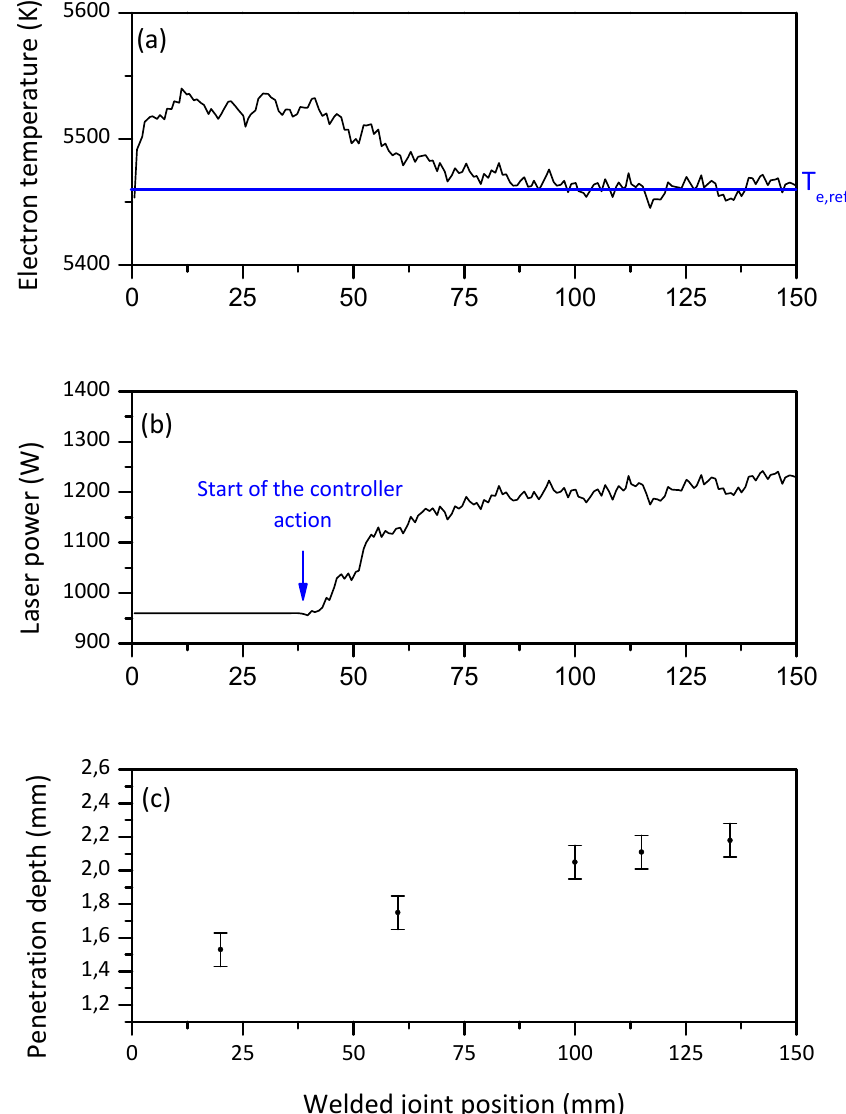
Figure 5. ( a ) Electron temperature signal behavior. Controller parameters: T corresponding to a penetration depth of 2 mm; K power = 960 W. ( b ) Laser power measured by fast power sensor. ( c ) Penetration depth